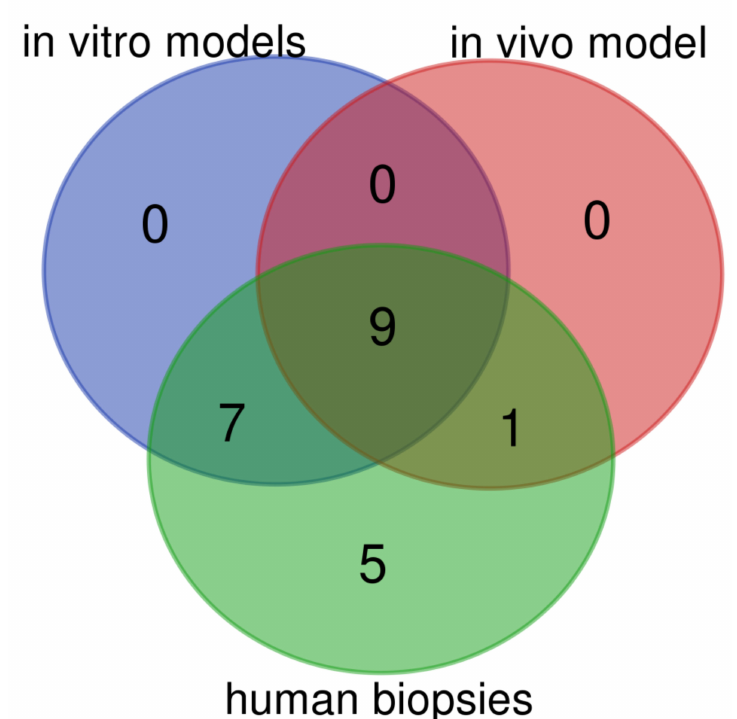
Figure 12. Venn diagram displaying numbers of up / downregulated genes in human biopsies derived from patients with Barrett’s metaplasia as compared with in vitro (Het-1A and EPC2) models and surgical animal model of Barrett’s esophagus. Overlap area shows the number of the same up / downregulated genes in the appropriate groups. Graphs were obtained through Venn diagrams software (available online: http: // bioinformatics.psb.ugent.be / webtools / Venn / ). Di ff erent colors mean di ff erent